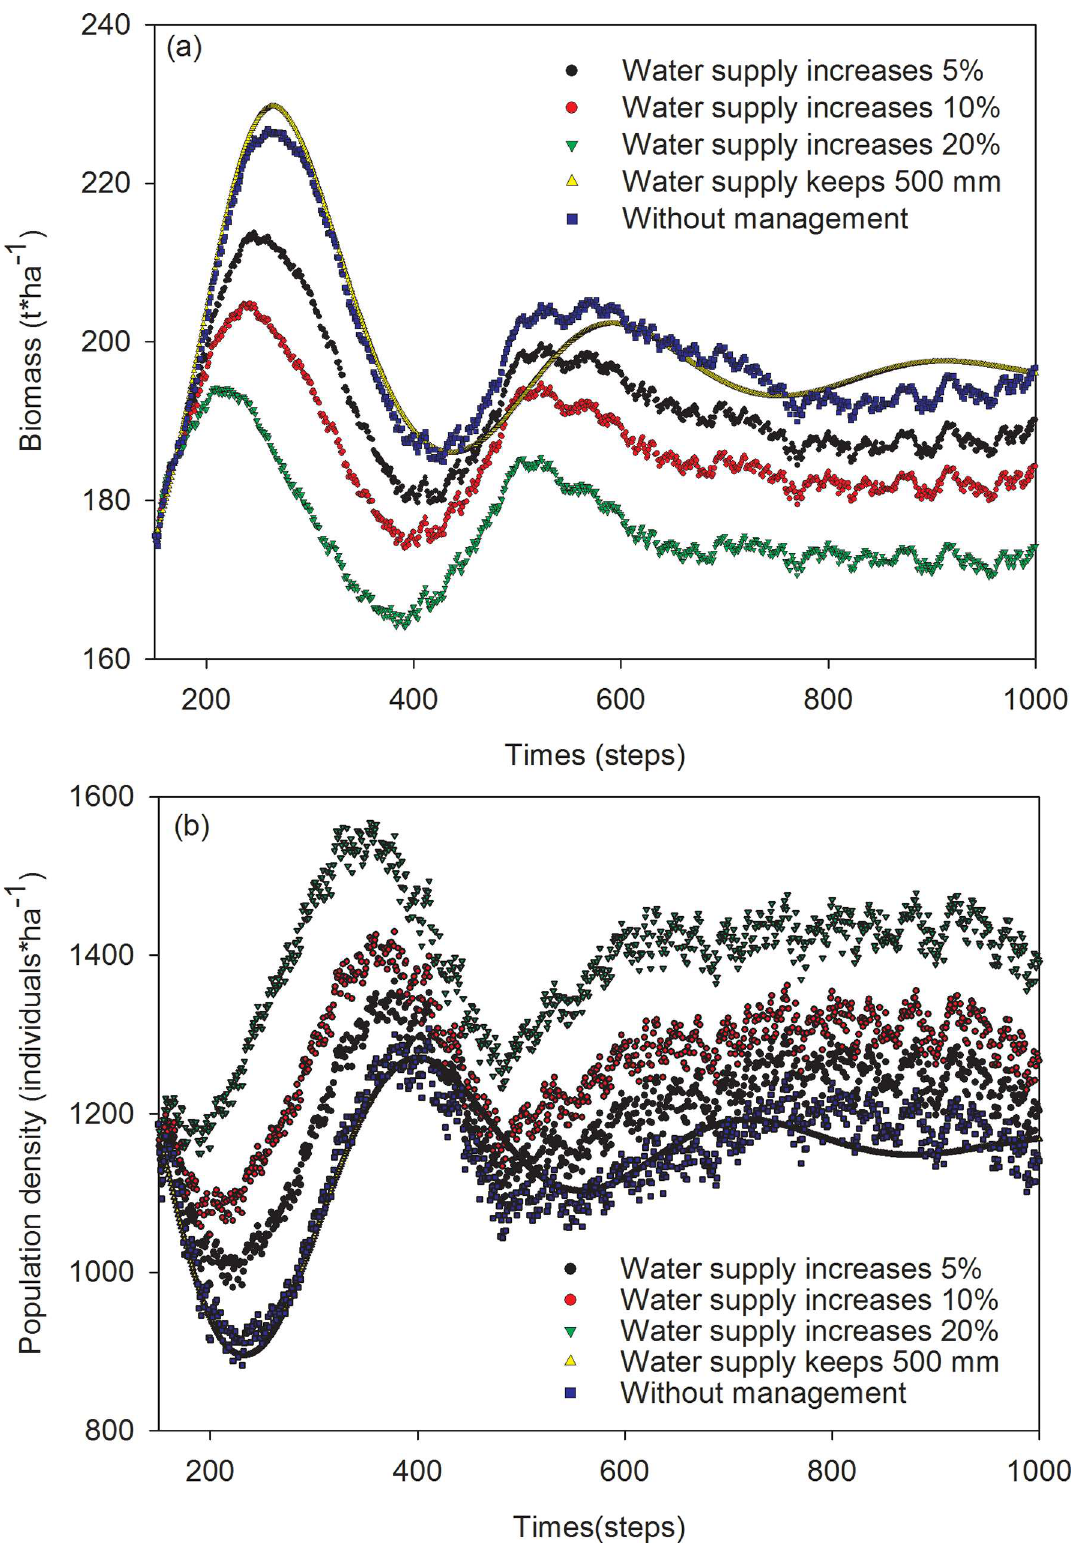
Fig 2. Simulationresults of the effects of increasingwater supply on biomass (a) and populationdensity (b) of Mongolian pine